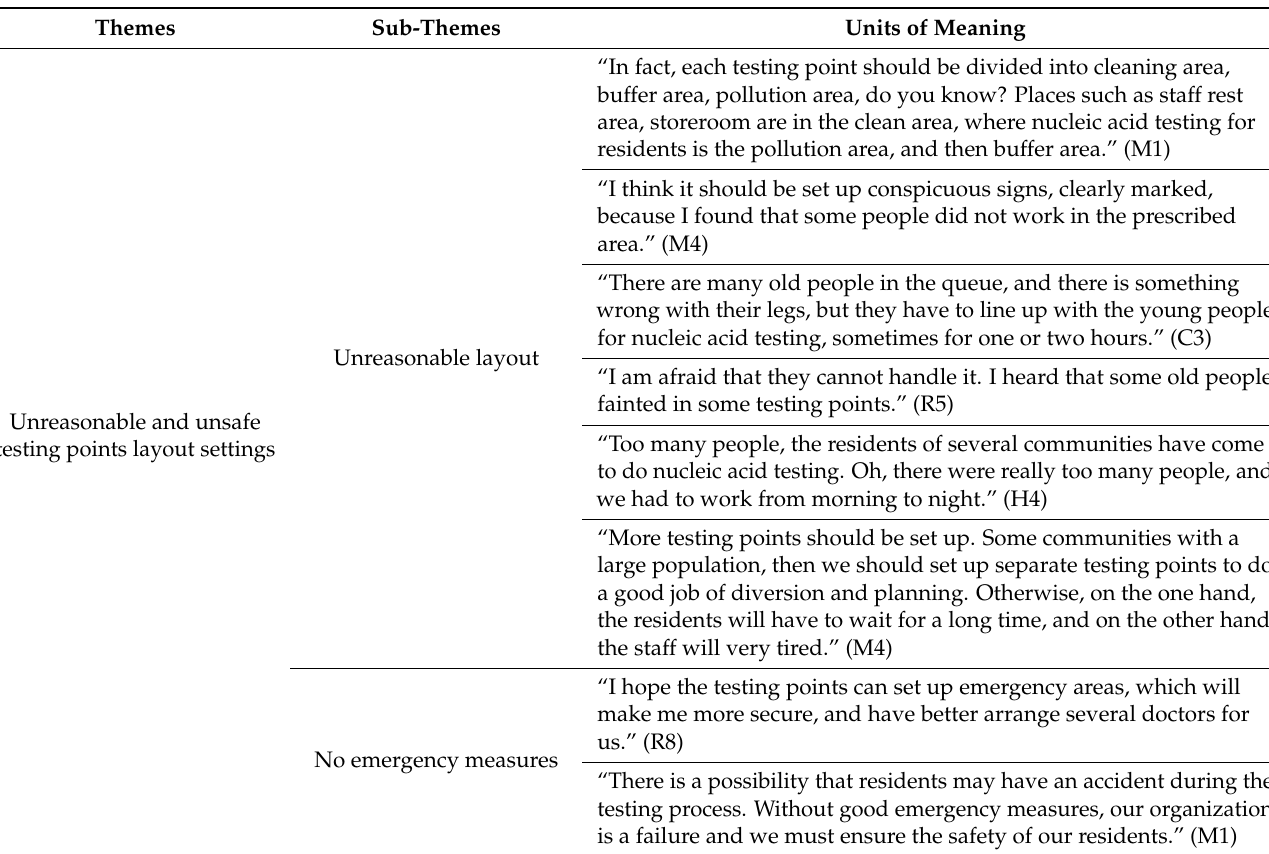
Table 4. Themes, sub-themes and units of